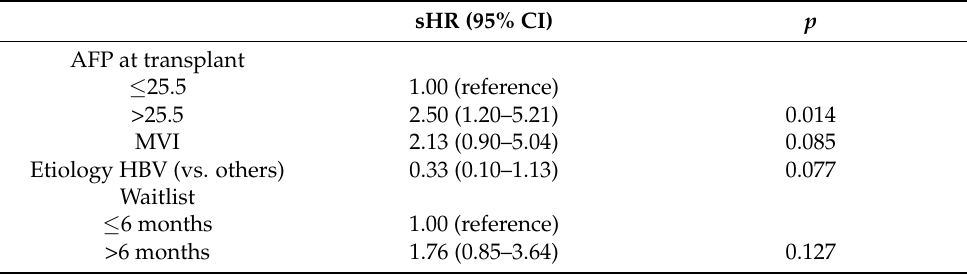
Table 2. Multivariable Fine–Gray proportional sub-distribution hazard model for recurrence after liver transplant (death was considered as a competing event).